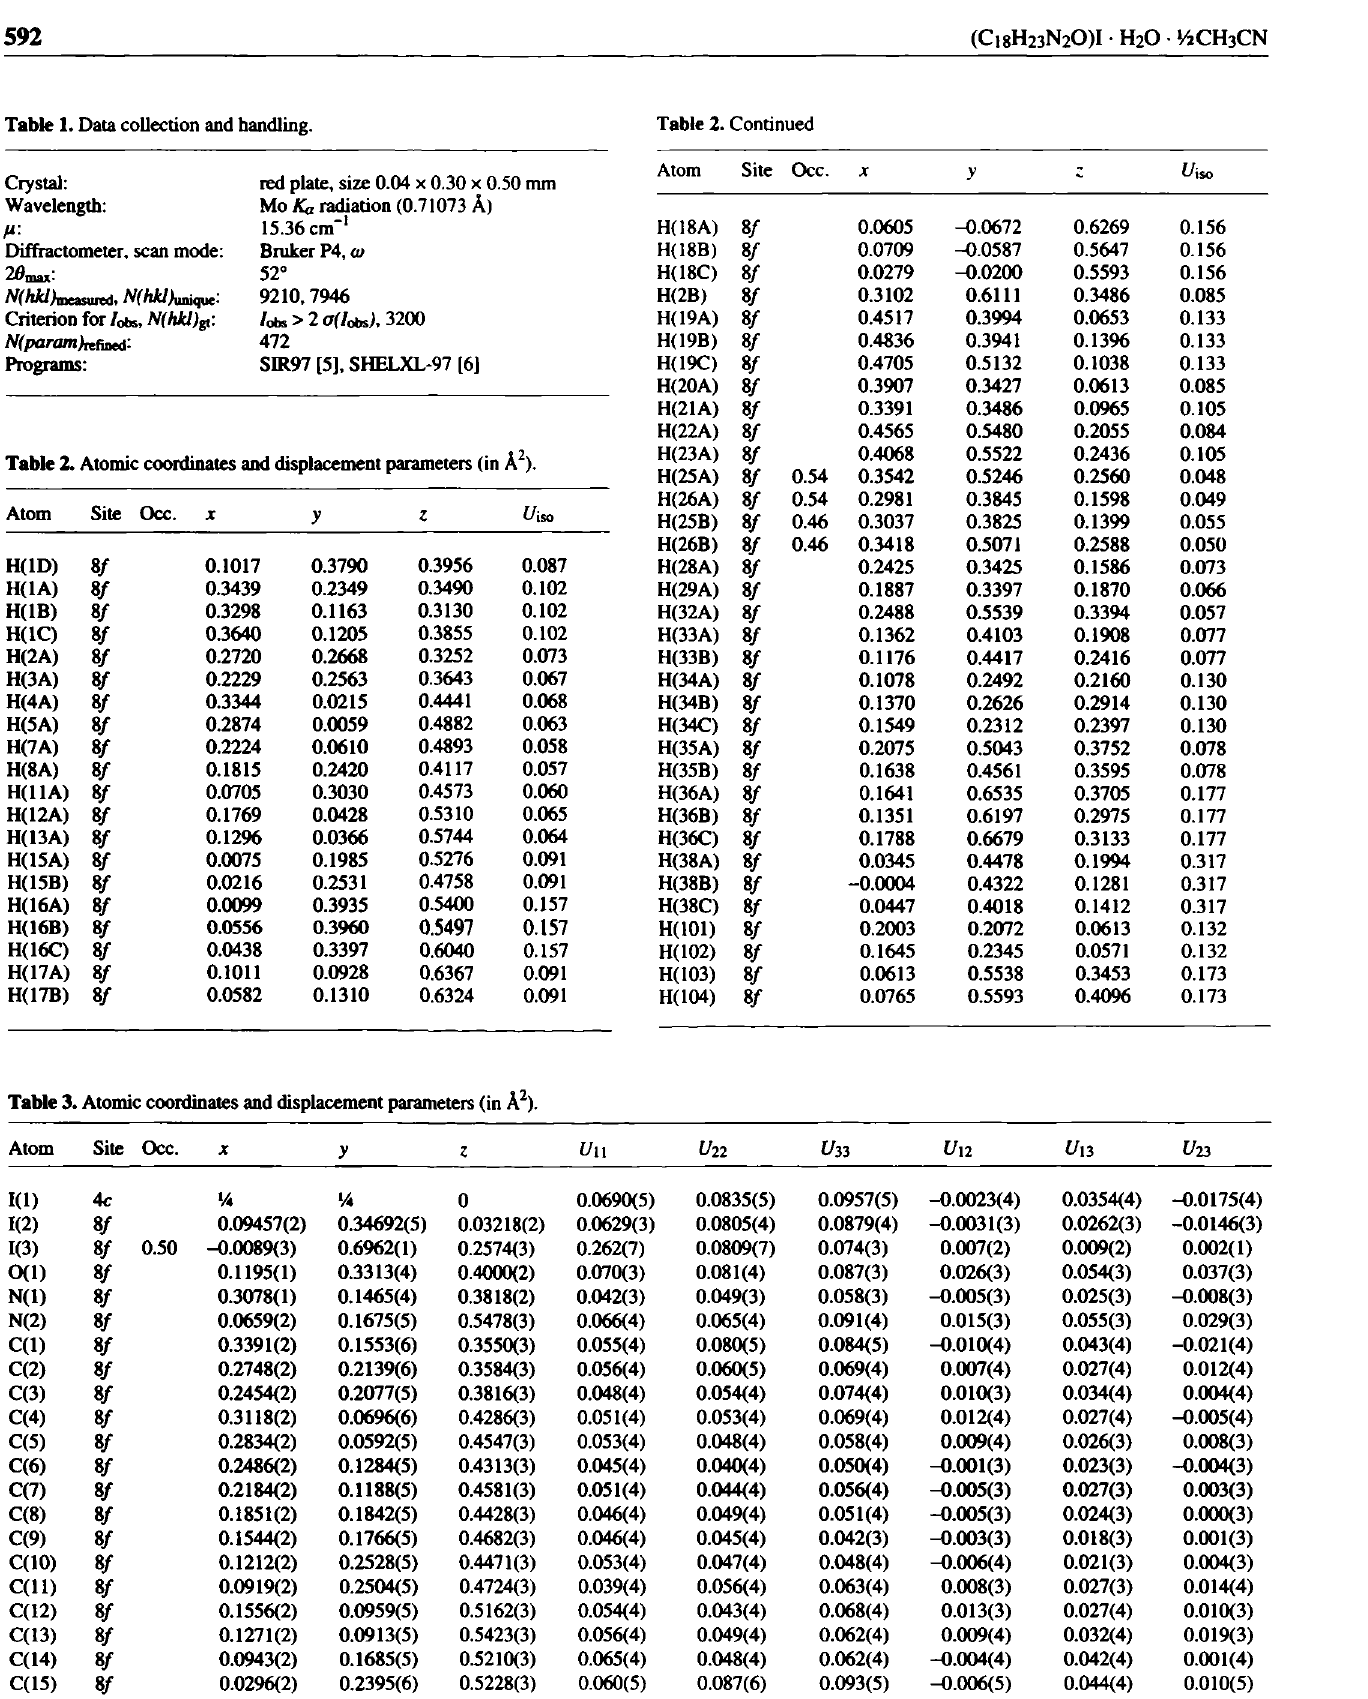
Table 3. Atomic coordinates and displacement parameters (in A 2